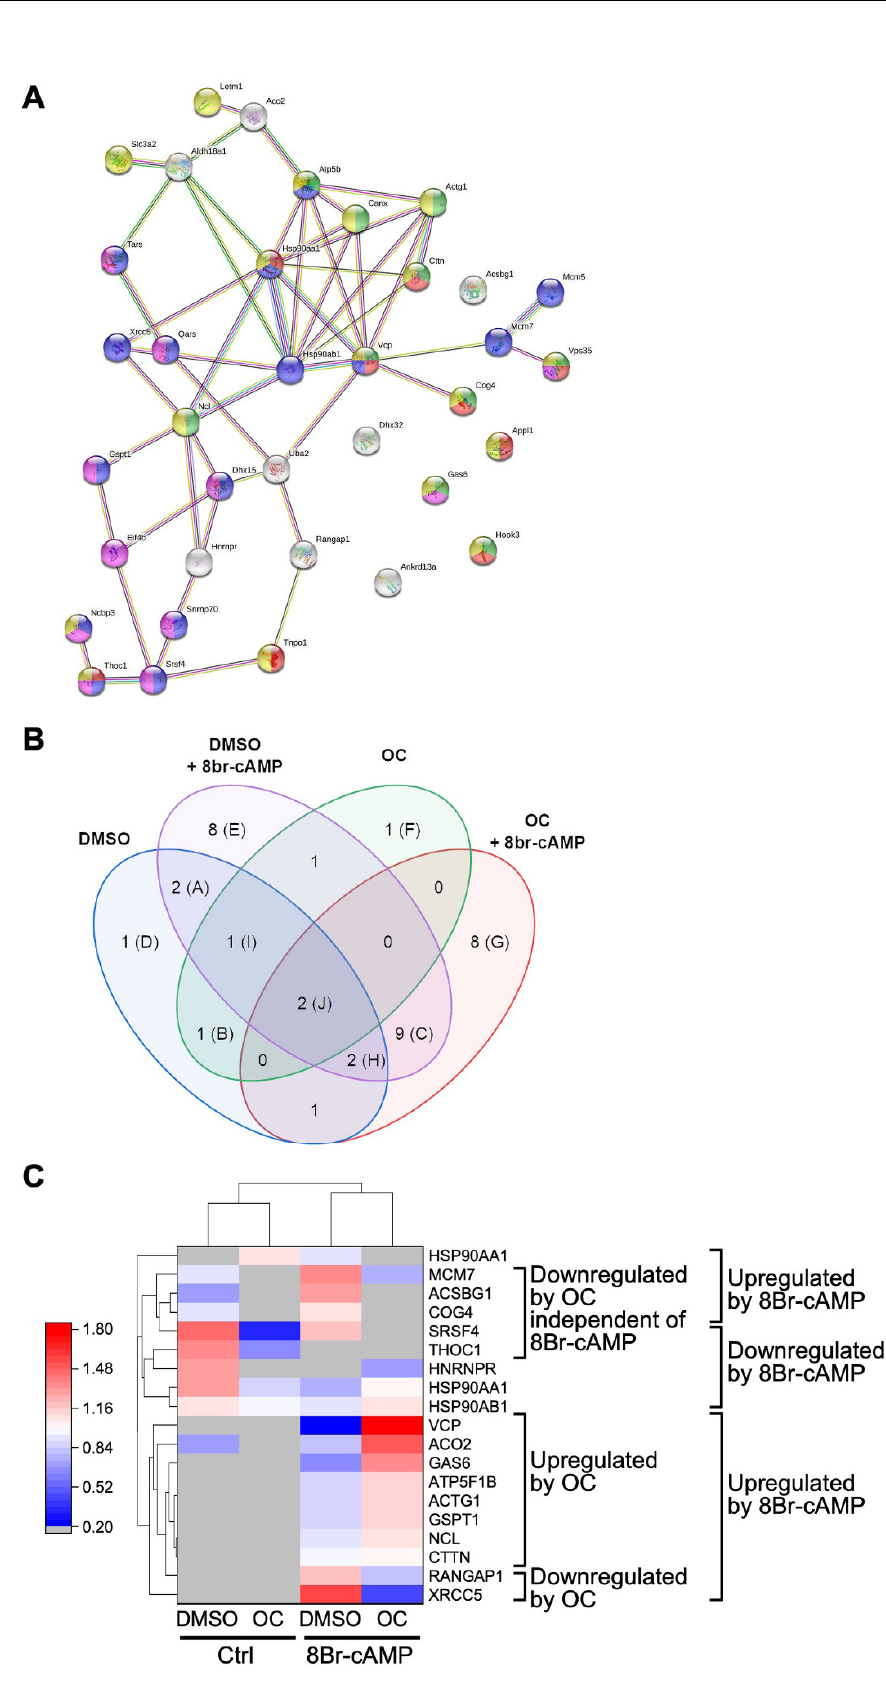
Figure 4. Proteomic profiling of Sample 1 shows proteins that are potentially affected after exposure of Leydig cells to an OC mixture. MA-10 Leydig cells were treated with either DMSO or 10 µg/mL of the OC mixture for 2 h and then treated for another 4 h with or without 0.1 mM 8Br-cAMP, as